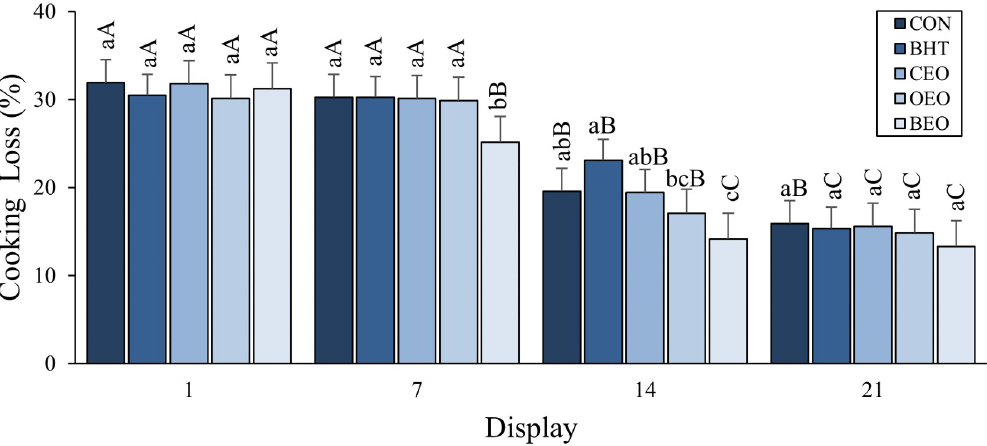
Fig 3. Evolution of cooking losses in beef patties treated with BHT, copaiba and oregano essential oil or blend of essential oils during display.